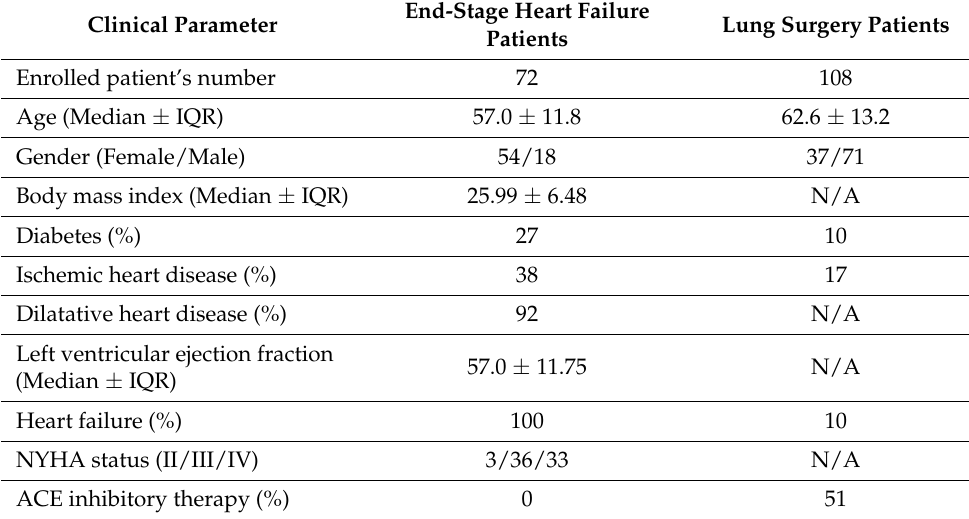
Table 1. General clinical information on the patients